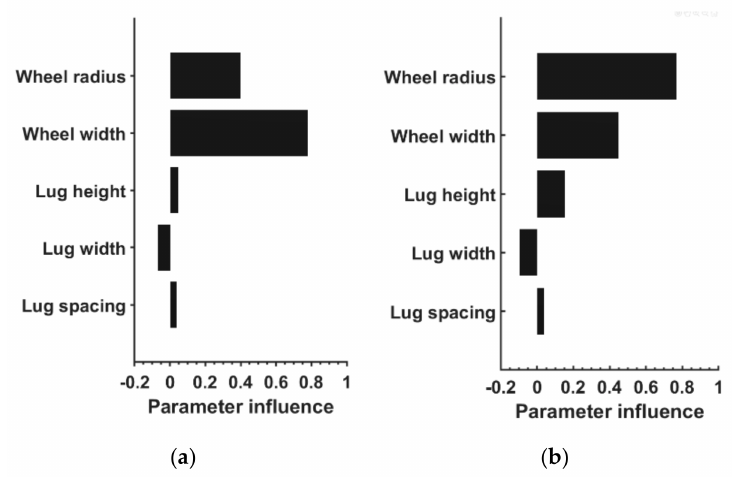
Figure 10. Sensitivity analysis results with respect to wheel geometry parameters: ( a ) parameter influence for the drawbar pull according to various aspects of wheel geometry; ( b ) parameter influence for the power consumed according to various aspects of wheel